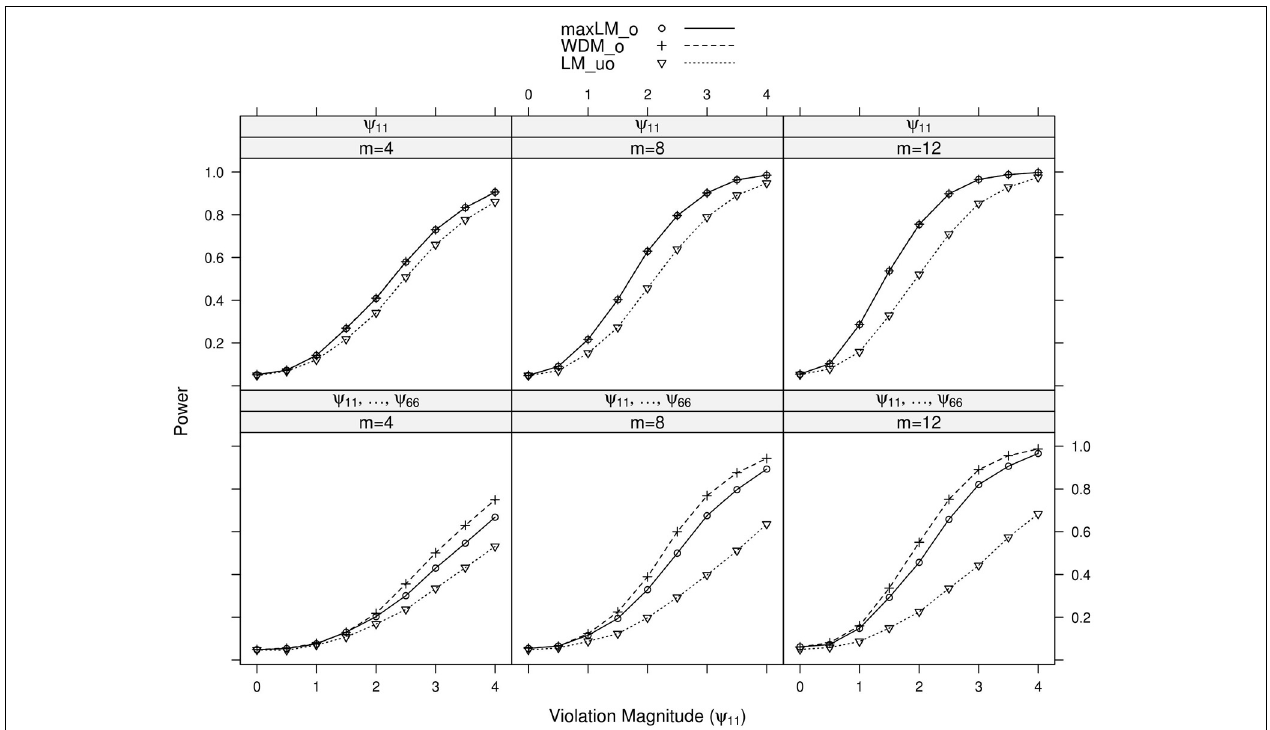
FIGURE 5 | Simulated power curves for max LM o , WDM o , and LM uo across three levels of the ordinal variable m and measurement invariance violations of 0–4 standard errors (scaled by